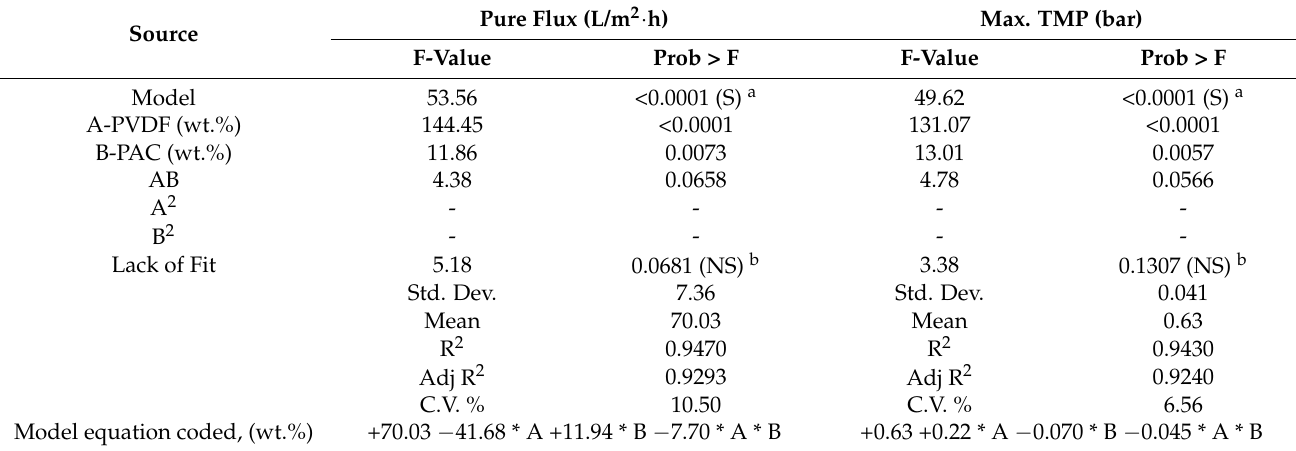
Table 4. ANOVA results and quadratic models of PVDF-PAC membranes for pure flux and max. TMP.